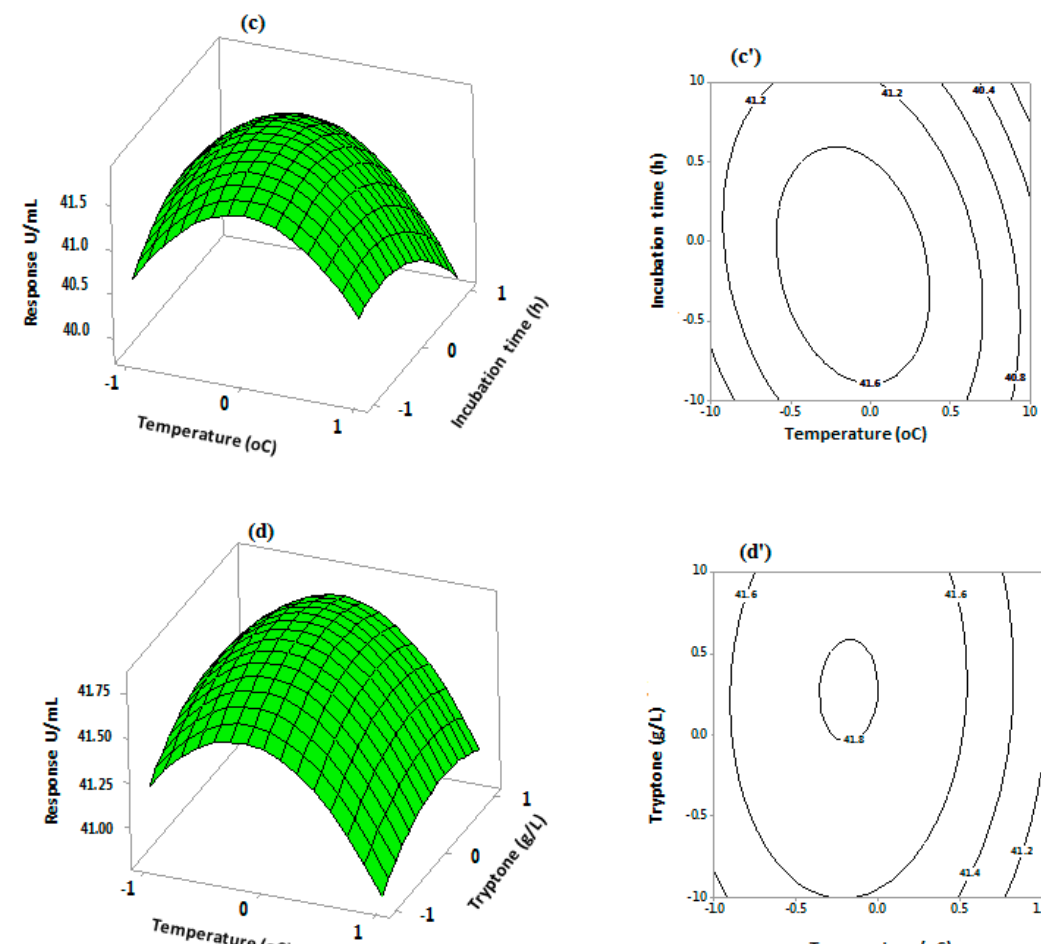
Figure 6. Three-dimensional response surface and contour plots for S.griseus recombinant β -glucosidase production using a three level Central Composite Design. The plots depict the interactive effects of: OD 600 nm and temperature ( a , a’ ); OD 600 nm and incubation time ( b , b’ ); temperature and incubation time ( c , c’ ); and temperature and tryptone ( d , d’ ). The remaining variables remained at constant zero levels.